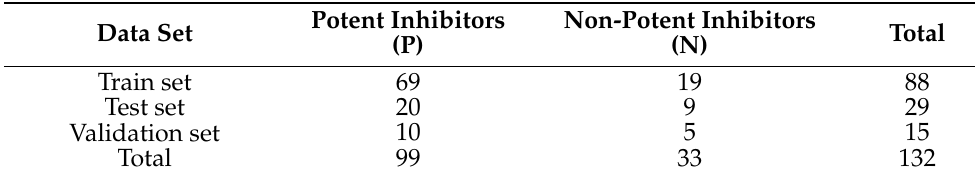
Table 4. The statistics of molecules in the